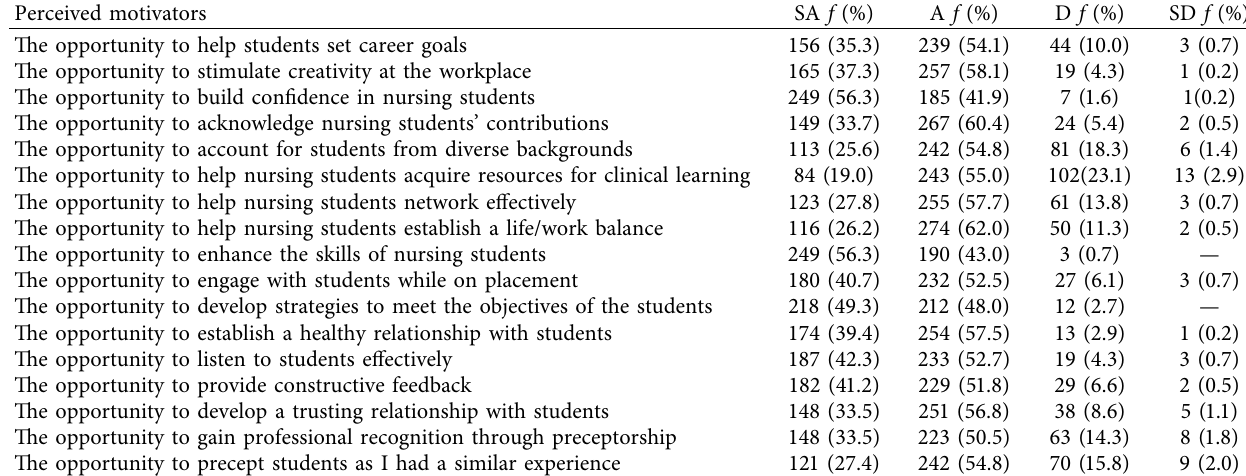
Table 2: Descriptives on the perceived motivators to precepting nursing students ( N �